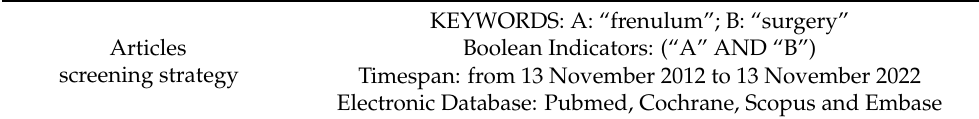
Table 1. Database search indicator.